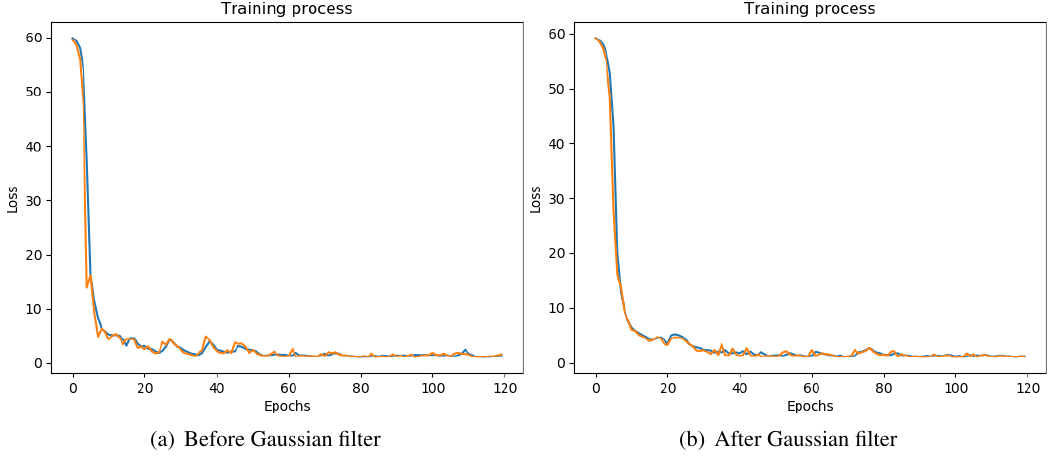
Fig. 6 Training process of RSOA. RSOA, reference signal optimisation